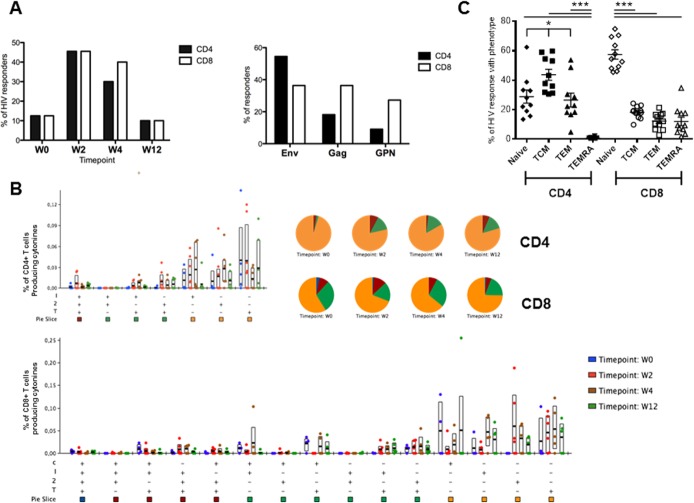
Frequency, function and phenotype of HIV-specific T cell responses.A: Percentage of responders with positive ICS responses against Env+Gag+GPN at the different time points (left panel) and distribution of the CD4+ and CD8+ T cells by antigen (right panel). B: Functional profile of vaccine-induced T cells. The quality of the HIV-specific CD4 or CD8 T cell response is characterized by the proportion of cells making every possible combination of the measured cytokines: IFN-γ (I); IL-2 (2); TNF-α (T) and CD107a (C). Responses are grouped and colour coded on the basis of the number of functions. The bar charts show the mean values and interquartile ranges (IQR) and the pie charts show the average proportion of the HIV-specific CD4 or CD8 T cell responses according to the functions at weeks 0, 2, 4 and 12. “+”distributions that are different from the earliest time point (W0) within each category at p<0.05 (Student's T test). C: Phenotype of vaccine-induced T cells. The graphic represents the distribution of the responding HIV-specific CD4 and CD8 T cells at any time point based on CCR7 expression in combination with CD45RA within the Naïve (CD45RA+ CCR7+), T central memory (TCM: CD45RA- CCR7+), T effector memory (TEM: CD45RA- CCR7-) or terminally differentiated T effector memory (TEMRA: CD45RA+ CCR7-) phenotypes. Statistical differences were determined using ANOVA test (using the linear model y ~ x_patient + x_cellType + epsilon) followed by Tukey's honest significant difference criterion. *p<0.05, ***p<0.005.